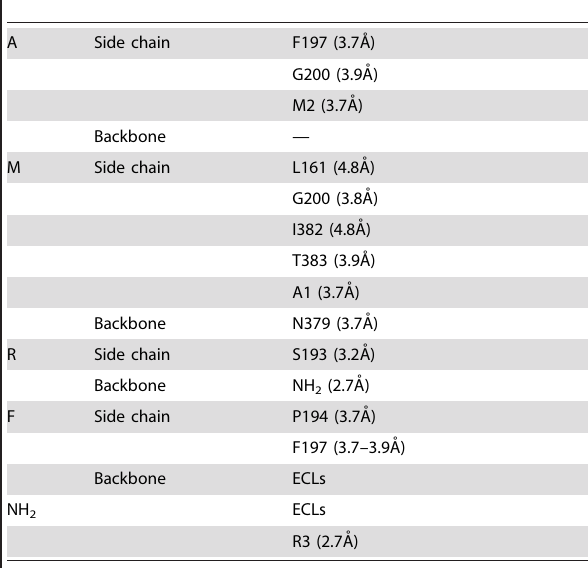
Table 5. AMRF-NH 2 ligand-receptor contact sites, pose A a